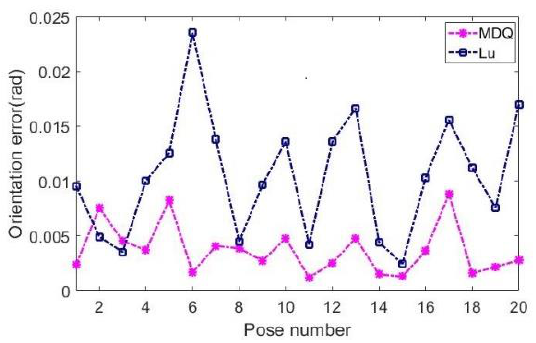
Figure 5. The RMS errors in rotation interfered with random noise.